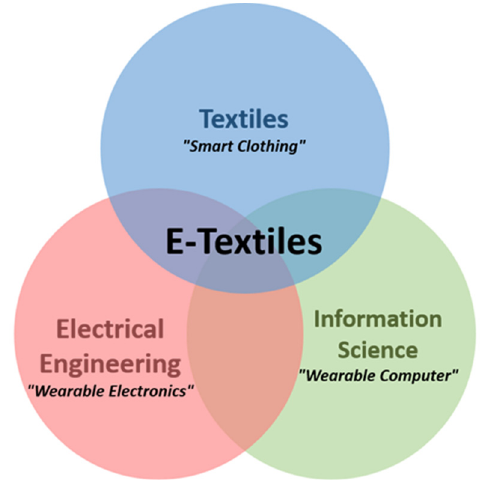
Figure 3. Classi fi cation of supersets of electronic textiles [148]. Reproduced with permission from Figure 3. Classification of supersets of electronic textiles [148]. Reproduced with permission Elsevier. from